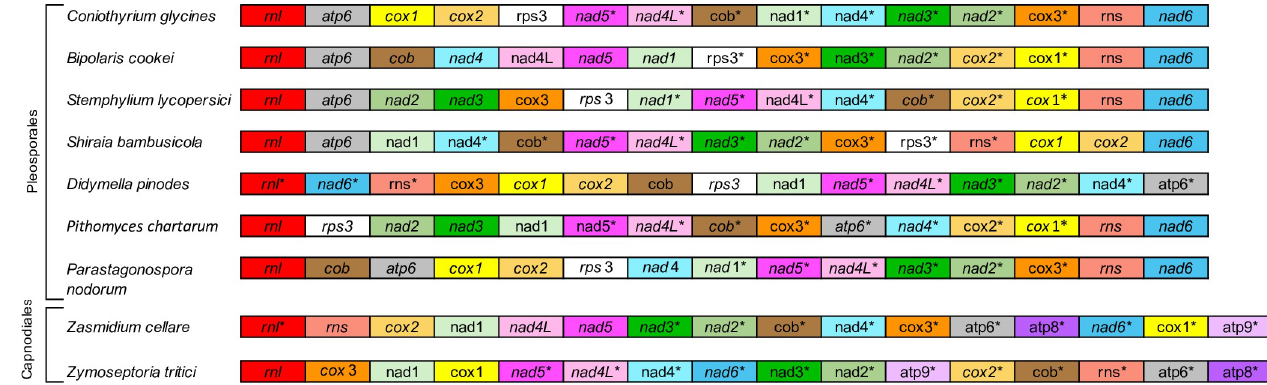
Fig 2. Mitochondrial genome rearrangements among Dothidiomycetes. Asterisk ( � ) indicates reverse direction of transcription. Each gene is assigned a separate color. Gene order was obtained from GenBank: Bipolaris cookei (MF784482), Didymella pinodes (NC_029396), Parastagonospora nodorum (NC_009746), Pithomyces chartarum (KY792993), Shiraia bambusicola (NC_026869), Stemphylium lycopersici (KX453765), Zasmidium cellare (NC_030334), and Zymoseptoria tritici (NC_010222).